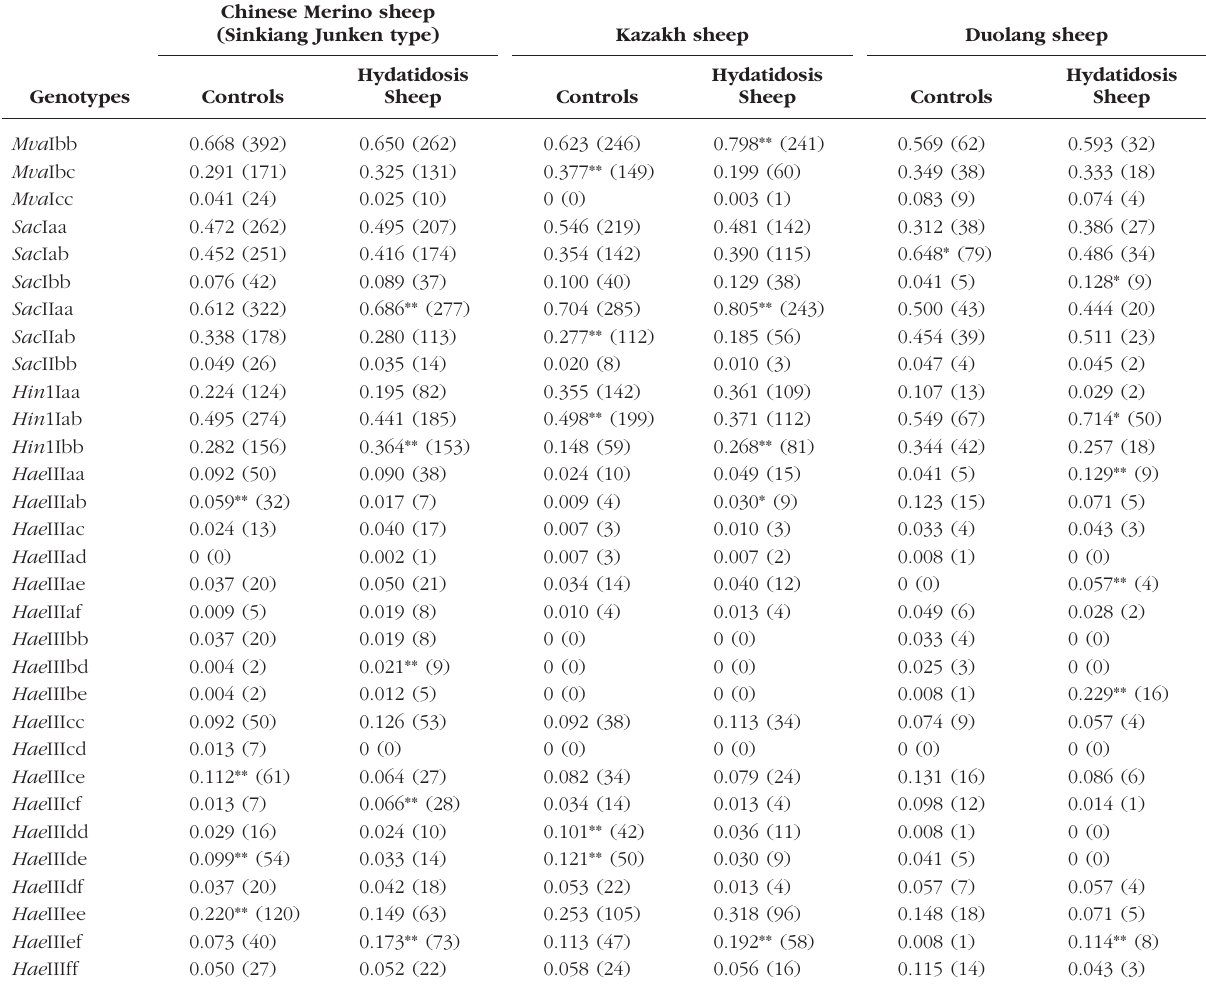
Table III. – Genotypic frequencies of the second exon of the MHC- DRB 1 gene in healthy group and hydatidosis group of three breeds